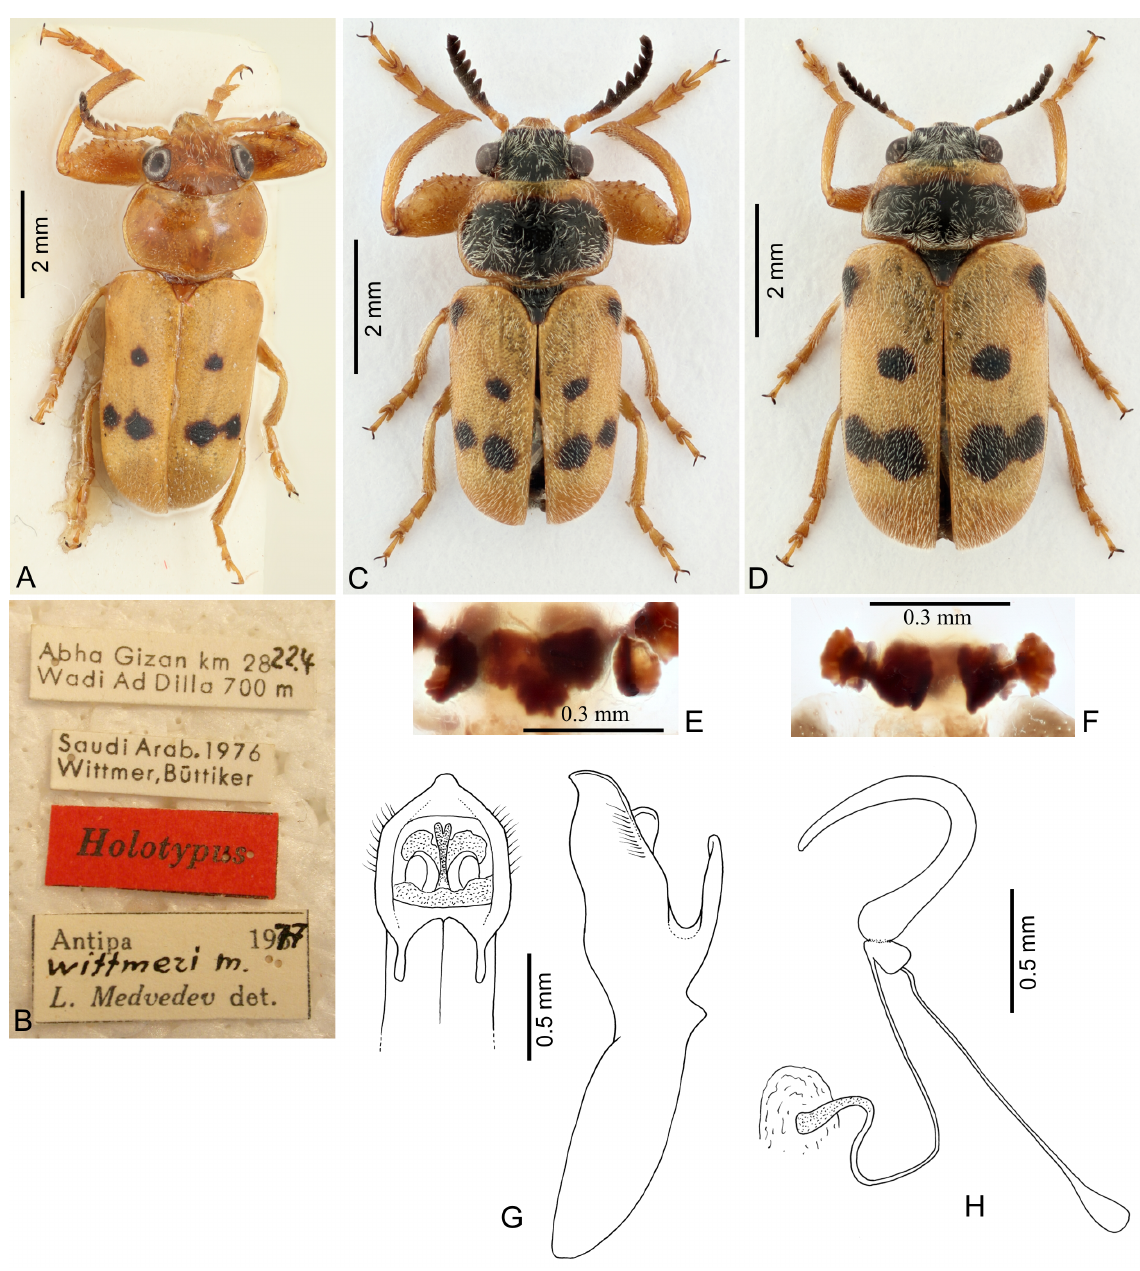
Fig. 11. Saudiclytra wittmeri (Medvedev, 1979). A . Holotype, ♂, 7.5 mm (NHMB). B . Labels of holotype. C . ♂, 6.3 mm. D . ♀, 6.6 mm. E . Kotpresse, dorsal sclerites. F . Kotpresse, ventral sclerites. G . Aedeagus in dorsal and lateral views. H .